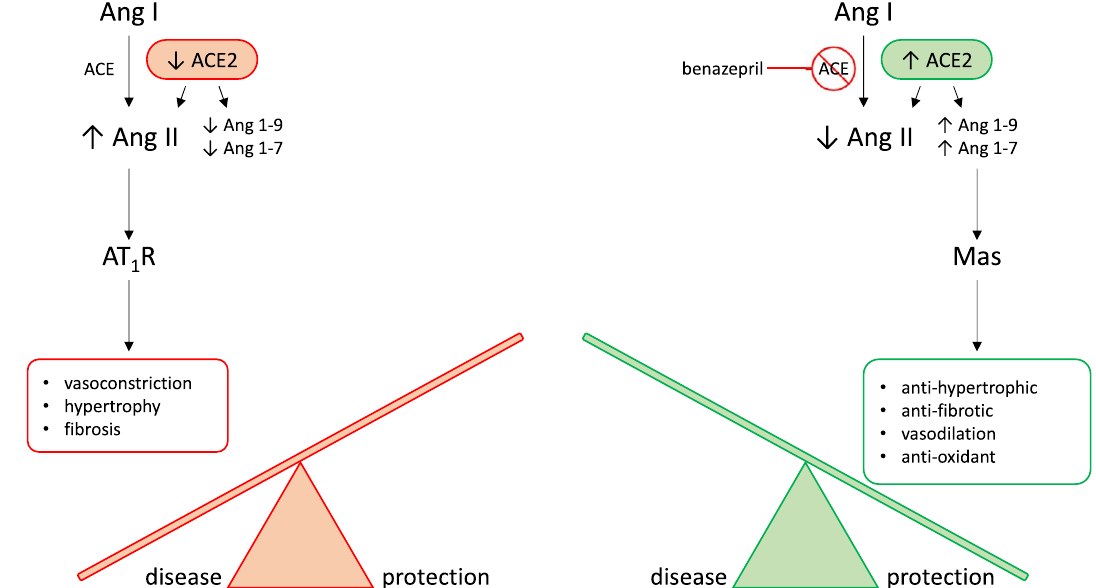
Figure 1. Biological arms of the RAAS. RAAS activation is thought of as having two main pathways which act as counterregulatory mechanisms for one another. The classical RAAS pathway (in red orange) refers to the peptide cascade from angiotensin I (Ang I) to angiotensin II (Ang II) via ACE. This stimulates aldosterone production which then activates AT 1 receptors (AT 1 R). Physiologic consequences of classical RAAS activation, including vasoconstriction, hypertrophy, and fibrosis, typical worsen congestive heart failure (CHF).